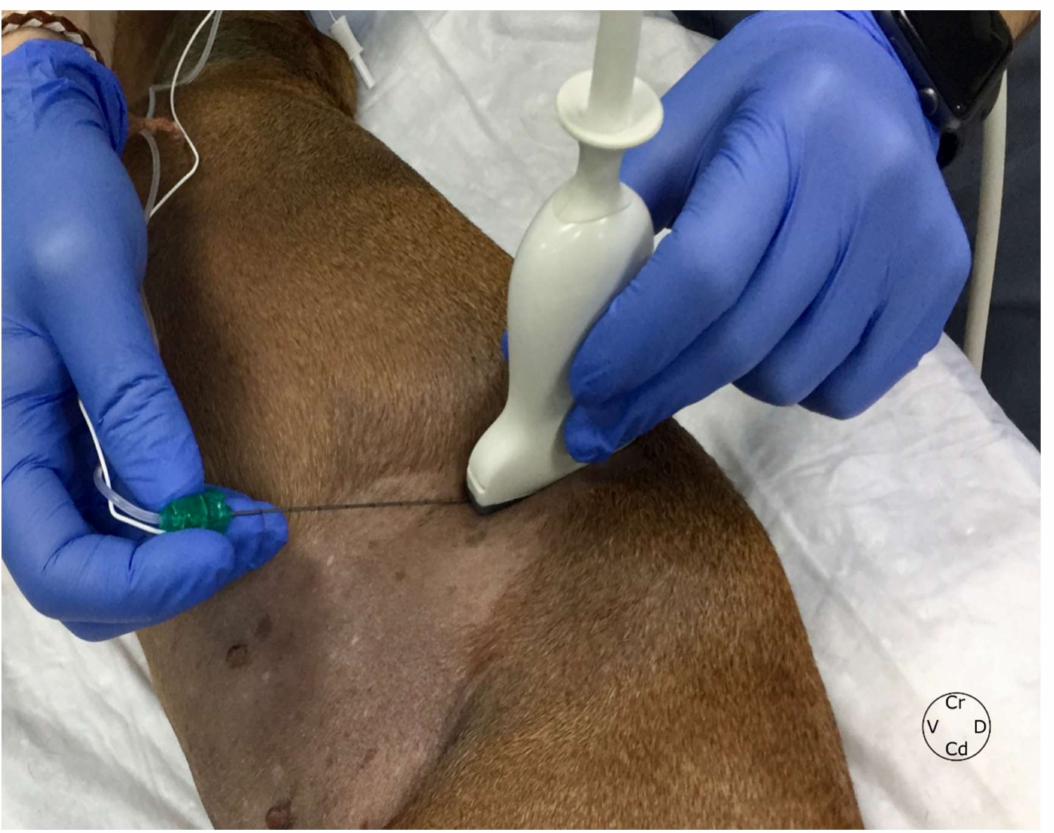
Figure 2. Ultrasound-guided approach to perform the QL block in dogs. Animals were positioned in lateral recumbency, and the transducer placed parallel to the last rib. The needle was inserted “in-plane” at the L1 level. QL, quadratus lumborum, L1; first lumbar vertebra, Cr, cranial; Cd, caudal; V, ventral; D,